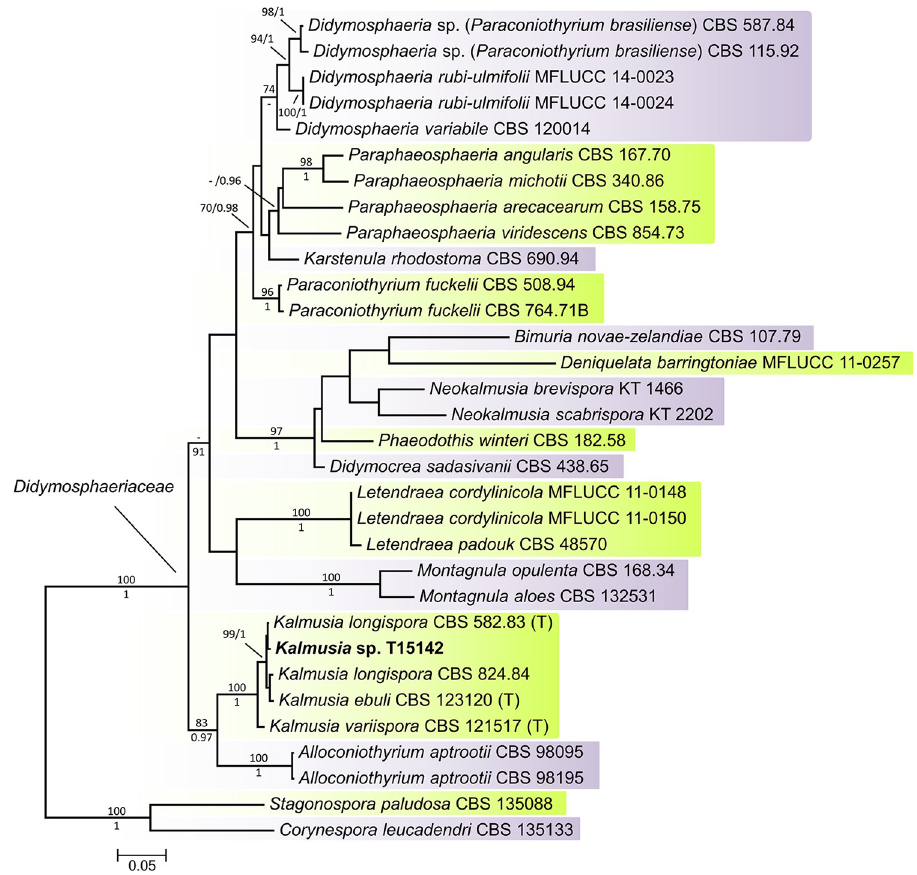
Fig 1. Maximum likelihood (RAxML) tree of concatenated internal transcribed spacer (ITS), partial large ribosomal subunit (LSU), and partial β -tubulin (TUB) sequences of the representative species of Didymosphaeriaceae . Bayesian posterior probabilities ( � 0.90) are shown below branches and after slashes; RAxML bootstrap support values ( � 70) are shown above branches and before slashes. The strain introduced in this study is shown in bold. Corynespora leucadendri and Stagonospora paludosa served as outgroups. The Kalmusia genus type materials (T) are indicated. The scale bar indicates the expected changes per site per branch. the K . longispora ex-type strain CBS 582.83, respectively [15]. The results of the molecular phy- logenetic analysis unambiguously show that the isolate T15142 represents K . longispora .